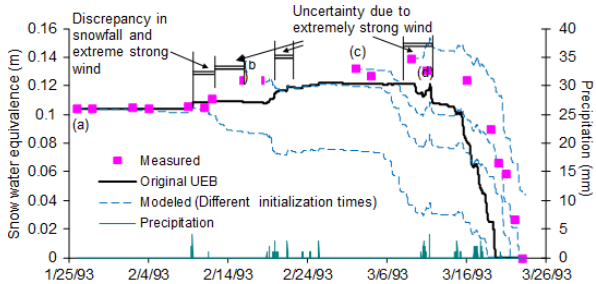
Figure 5. Comparisons of snow water equivalent in 1993 at the USU drainage farm. The dashed lines are the modeled values with new model starts at different times. Precipitation input is shown (spiky line at the bottom) relative to the axis at the right. Letters (a) through (d) indicate points where the model was re-initialized following periods of likely erroneous inputs due to severe weather.